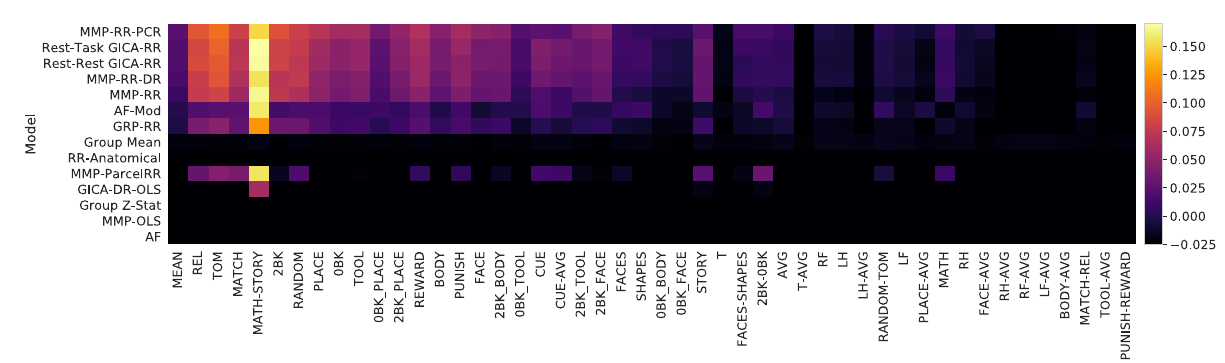
Figure 2. Pearson r correlation score benchmark results for 100 subject test set: Colorbar indicates mean r score across all test subjects for given contrast and model. Dashed black boxes indicate where model performance is significantly greater than test-subjects’s baseline (mean) model performance (one-sided paired sample t-test, p < 0.05 , 5000 permutations, Bonferroni corrected across contrast comparisons). Boxes in the left column mark baseline models. Scores are ordered top (best) to bottom (worst) by their subject-wise mean score computed across all 47 different contrasts (left-most column).